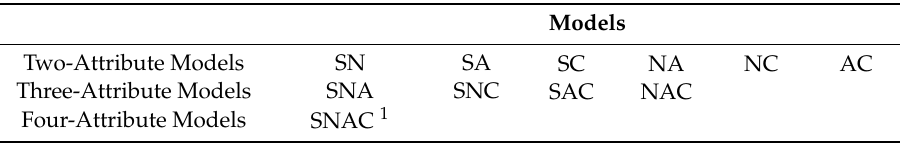
Table 4. Di ff erent methods involving combinations of